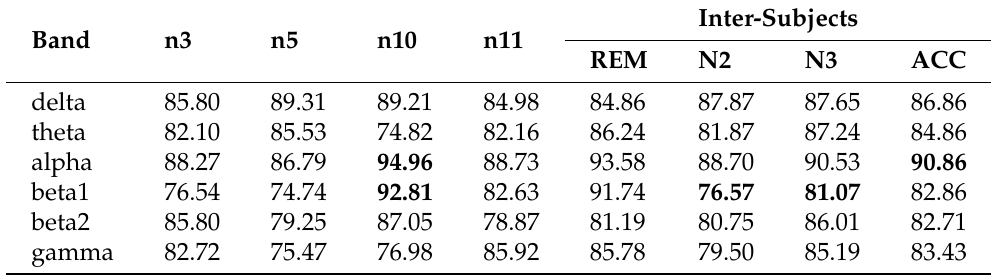
Figure 9. The discriminative ratio of per frequency band for distinguish two sleep stages (blue: REM and N2, orange: REM and N3, grey: N2 and N3). Table 2. Classification accuracy (%) of PLV value with single-band. For inter-subject case, the true positive rate of each class is also